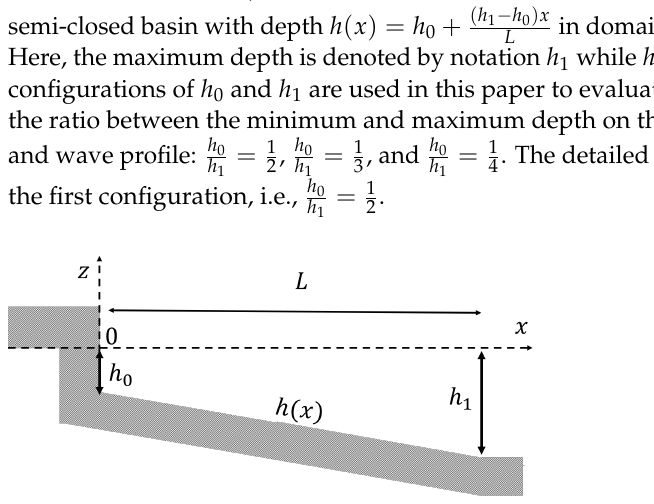
Figure 4. Trapezoidal semi-closed